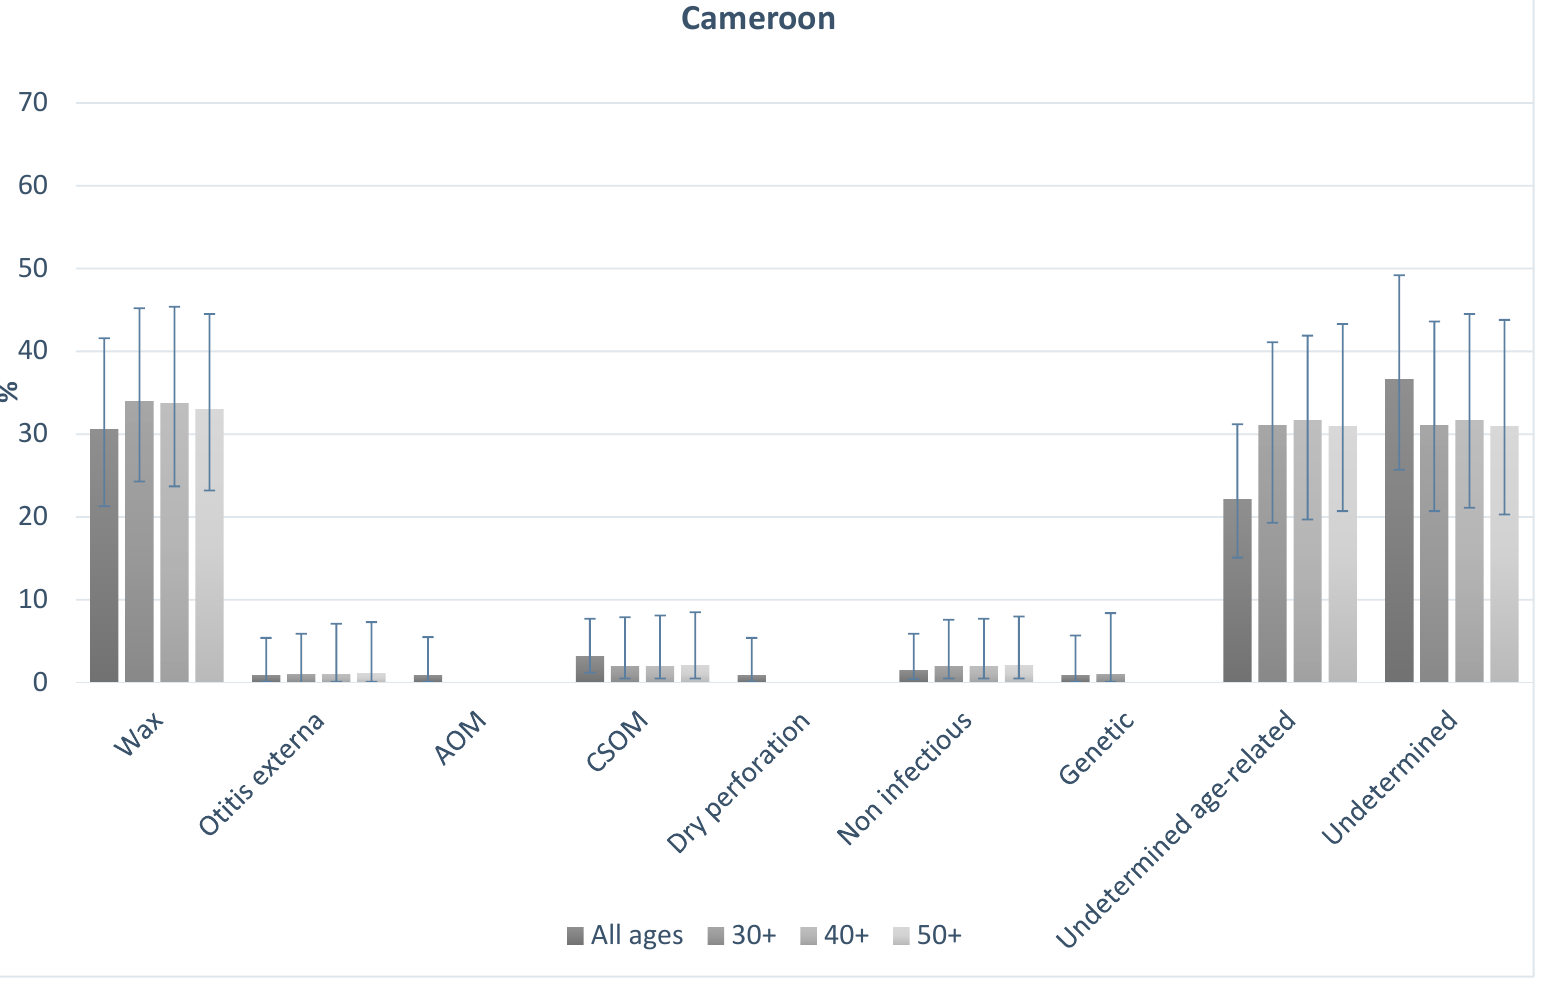
Figure 2. Probable causes of hearing loss in the population for all-ages and those aged 30, 40 and 50 plus in Cameroon.